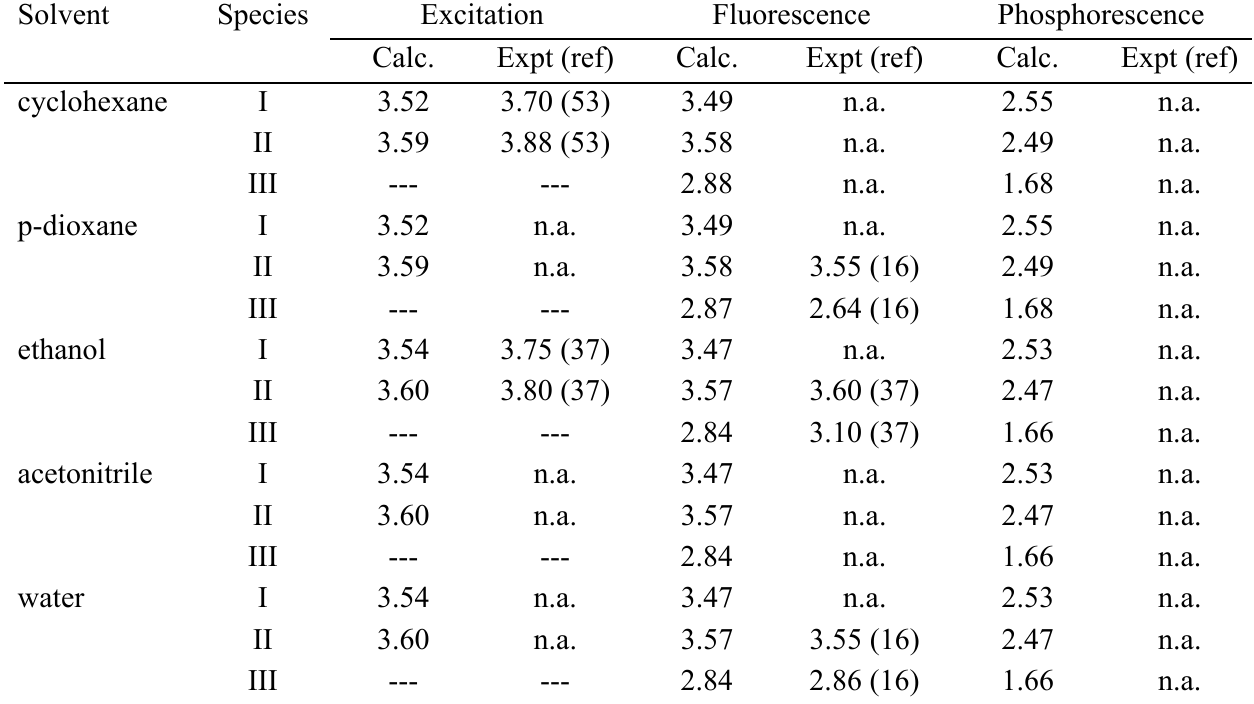
Table 10. Assignment of excitation, fluorescence and phosphorescence spectra of HBI in different solvents in terms of calculated energies (eV). Numbers within parentheses refer to the references corresponding to the experimental data. (n.a. indicates non-availability of